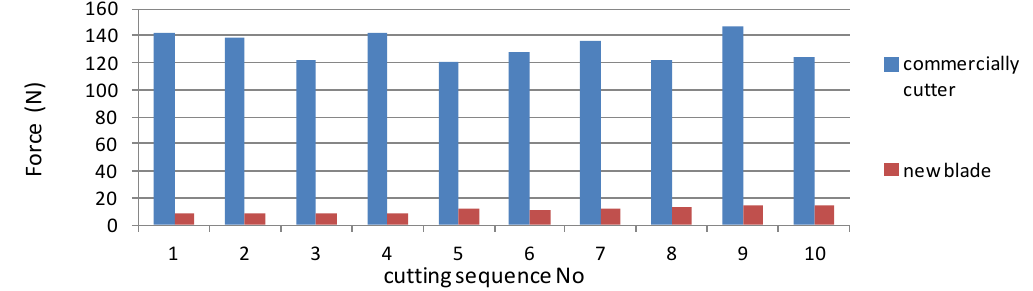
Figure 17. Measured manual force on the commercial and new